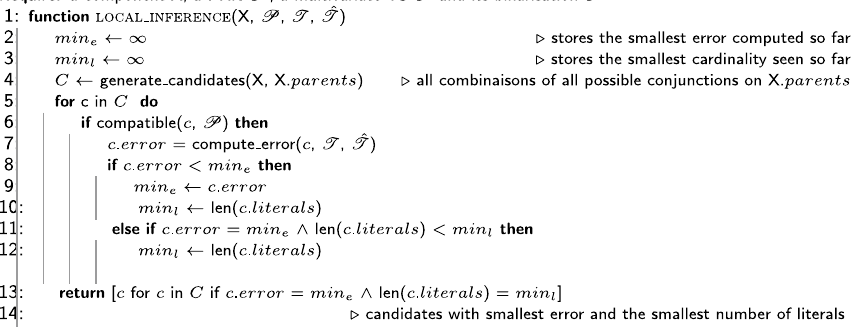
Fig. 4 Naive imperative algorithm for the local inference of